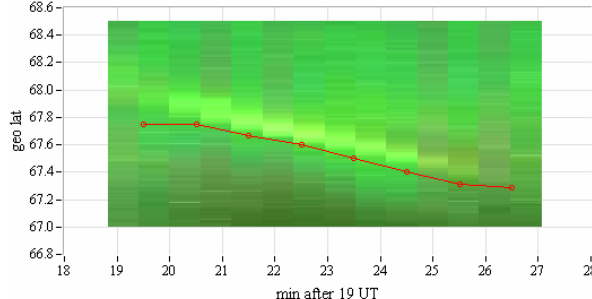
Fig. 4. Photo-emissions observed by ALFA imager in r-g-b chan-